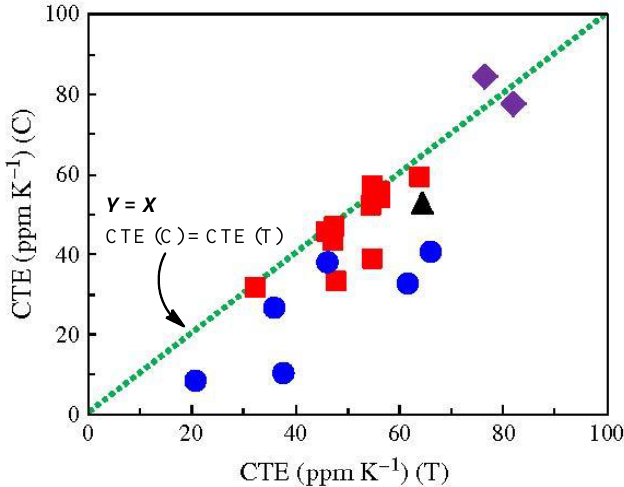
Figure 16. The effect of imidization method [chemical (C) and thermal (T) imidization processes] on CTE. ( ▲ ) 6FDA/TFMB, ( ♦ ) HTA-HQ-based systems, ( ■ ) H″-PMDA-based systems, and (●) TA-TFMB-based systems. Reproduced with permission from John Wiley & Sons [51].